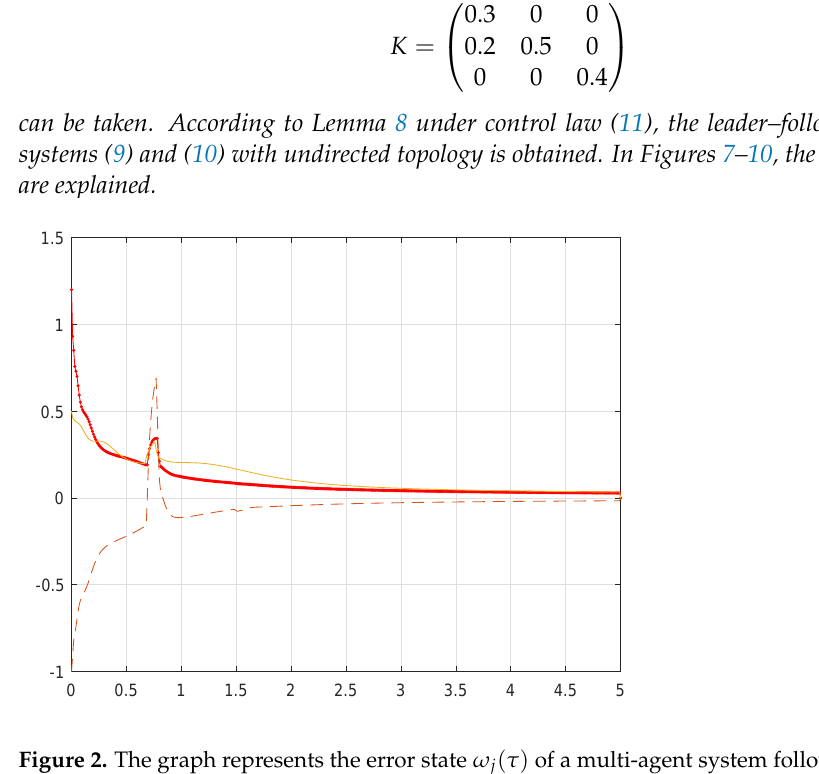
Figure 2. The graph represents the error state ω j ( τ ) of a multi-agent system following leader.